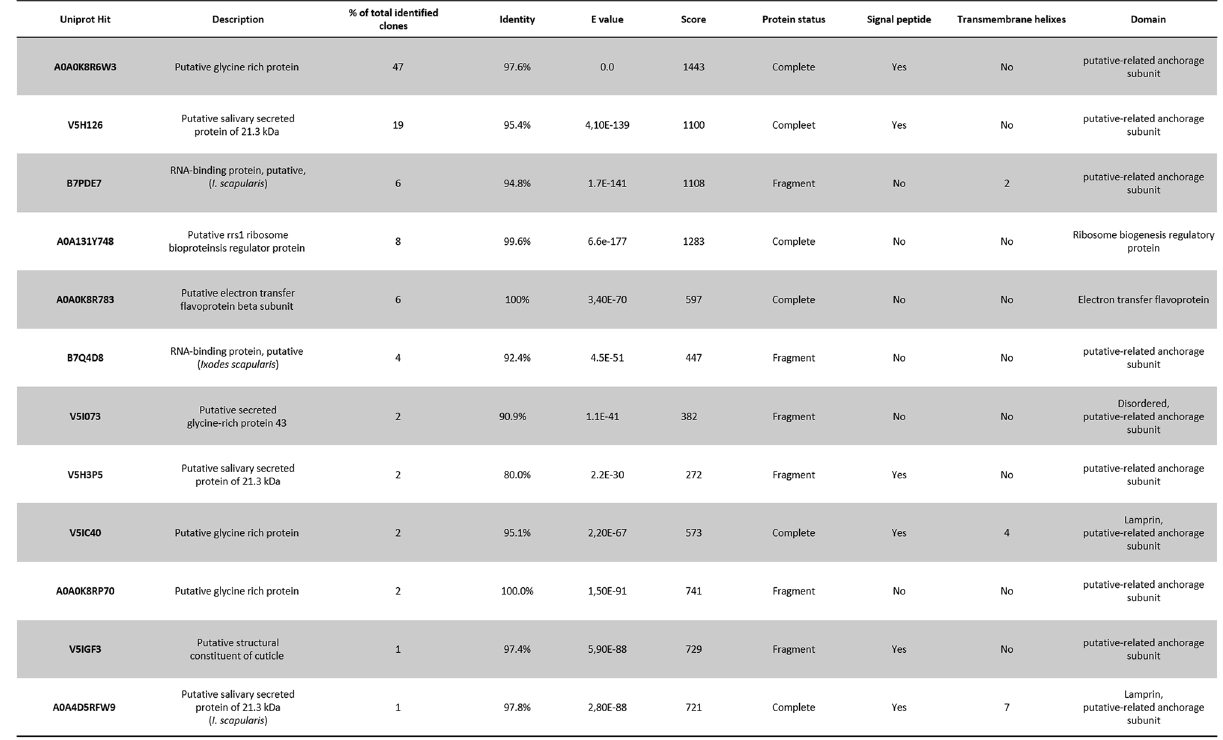
Table 1. Tick salivary gland proteins identified. Nucleotide sequences from the best clones for each identified TSGP were blasted against the UniProt database 35 resulting in identification of the TSGPs and subsequent Identity, E value, Score and protein status. Signal peptides were predicted based on amino acid sequence by SignalP 5.0 server 65 and HTHMM v2.0 server 66 was used to predict transmembrane helices. Proteins sequences were subsequently scanned for domains with InterProScan 67